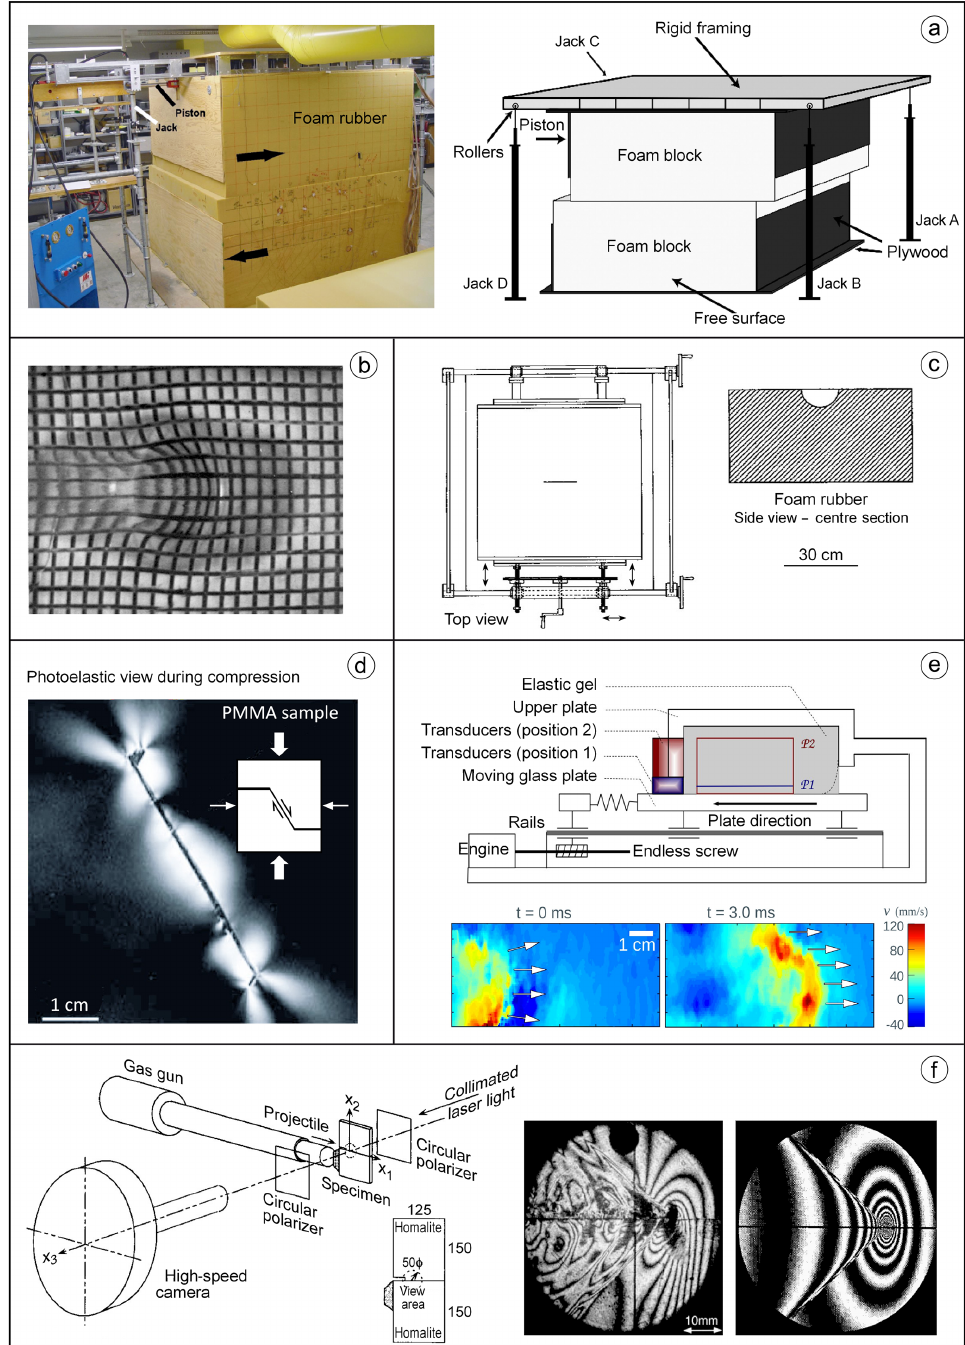
Figure 3. Examples of fault block models: (a) Brune’s foam block model as used in Brune et al. (1993), Anooshehpoor and Brune (2004) and Day et al. (2008) (image courtesy of Anooshehpoor and Brune, 2004; sketch modified from Day at al., 2008); (b) “Schallamach wave” pattern as seen in sliding rubber block experiments by Schallamach (1971) (image reproduced with permission from Elsevier); (c) foam rubber set-up after Archuleta and Brune (1975) (modified from there); (d) PMMA block set-up and photoelastic pattern visualizing stress in the vicinity of a crack from De Joussineau et al. (2001) (image reproduced with permission from Elsevier); (e) gel block set-up and resulting rupture pattern from Latour et al. (2013b) (modified from there); (f) homalite block set-up and photoelastic fringe pattern associated with rupture in experiments of Rosakis et al. (1999) (reproduced with permission from the American Association for the Advancement of Science).